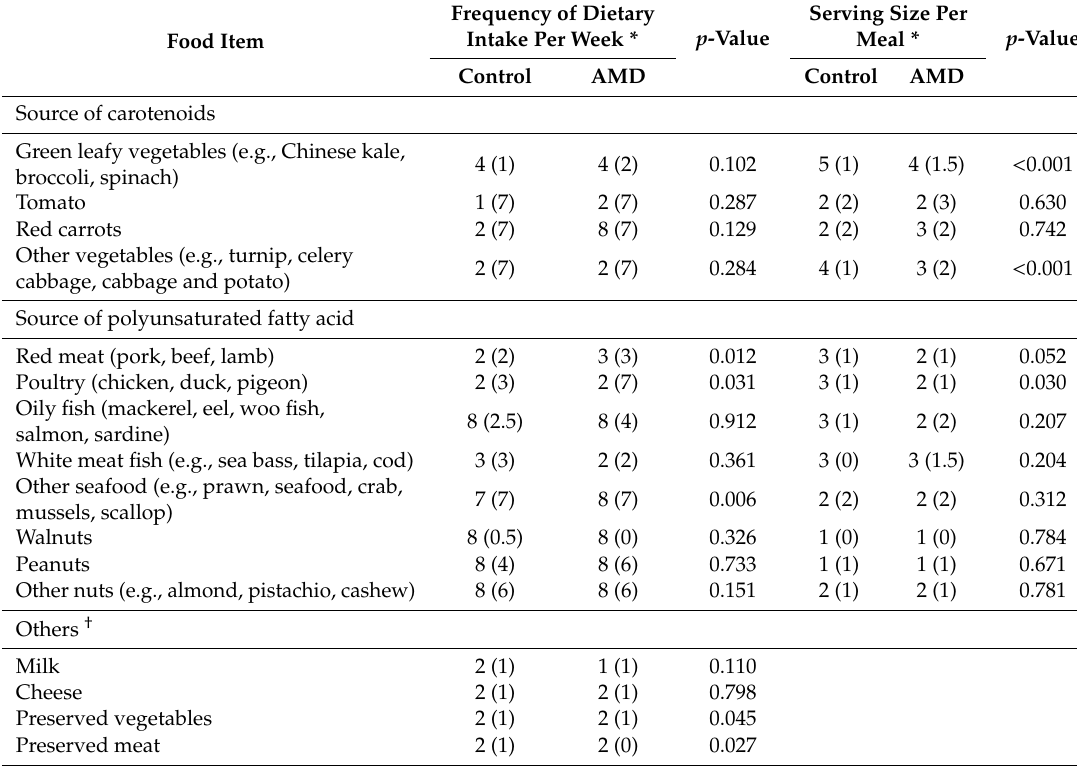
Serving Size Per Meal * p